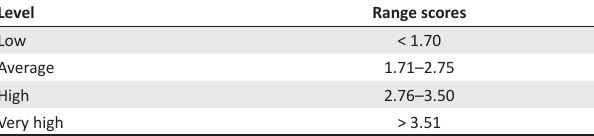
TABLE 2: Burnout score ranges (secondary symptoms).